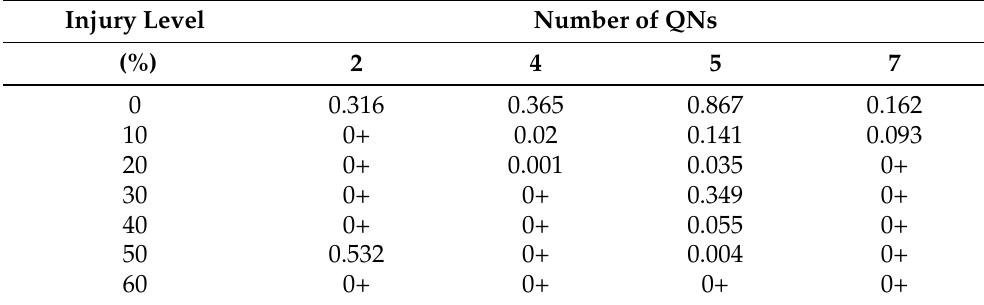
Table A8. P -values for normalized post-training responses (see Figure 5B). P -values are with respect to adjacent (next-lower) QN numbers. “0+” indicates p -value < 0.0005. N = 31 to 62 (mean =